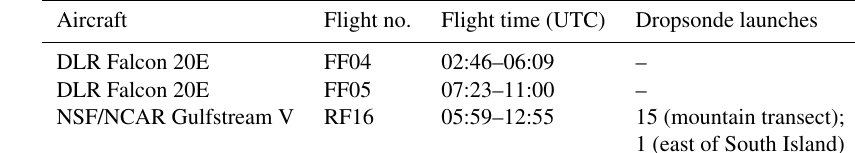
Table 2. Overview of the research flights on 4 July 2014 (FF = Falcon research flight, RF = GV research flight). Aircraft Flight no.